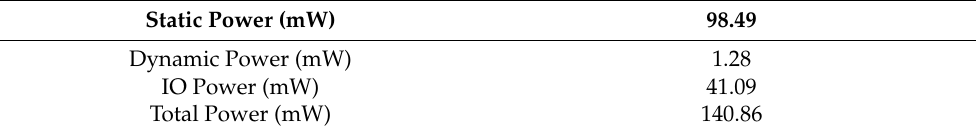
Table 9. Power dissipation analysis of the proposed TRNG.